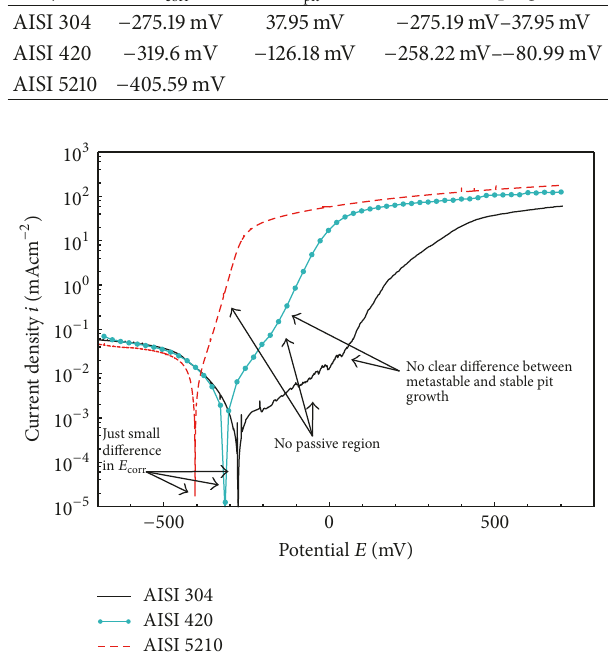
Figure 3: Potentiodynamic polarization scan in 3.5 wt.% NaCl solu- tion. The measurements are performed from − 700mV to 700 mV with a scan velocity of 1mVs −1 . All potentials are recorded against the Ag/AgCl